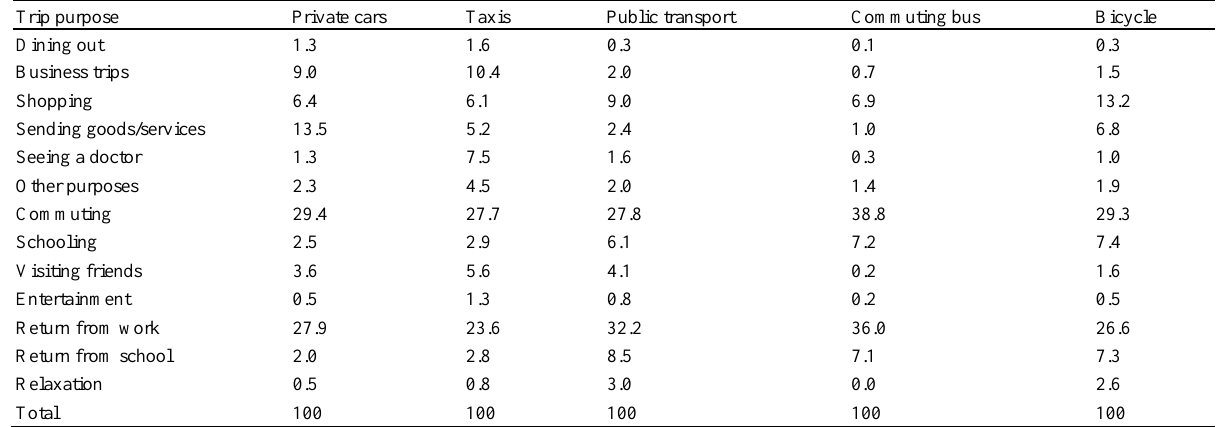
Table 8: Trip purposes and travel modes in Beijing (2005) (return trips neglected)